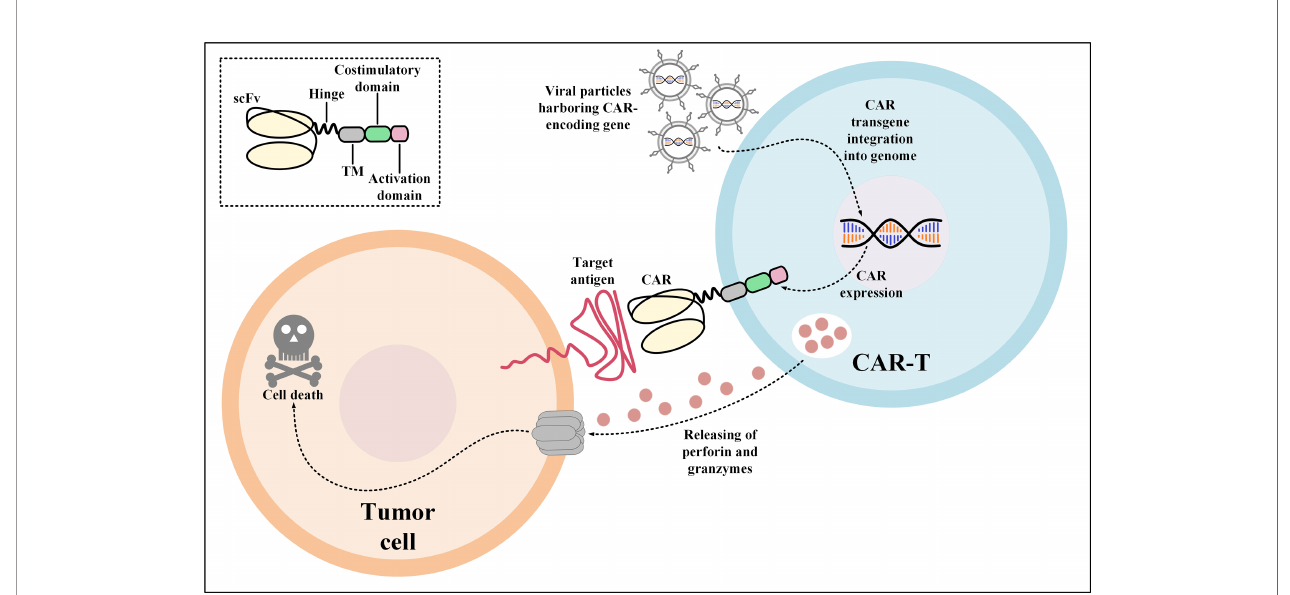
FIGURE 1 | Action mechanism of CAR-Ts for the elimination of target tumor cells expressing the CAR target antigen. Transduction of T cells with viral particles harboring the CAR-encoding transgene leads to the stable expression of CARs on the surface of the transduced T cells. Upon target antigen encountering, CAR-Ts are activated and they release perforin and granzymes leading to tumor cell death. CAR, chimeric antigen receptor; scFv, single-chain variable fragment; TM, transmembrane